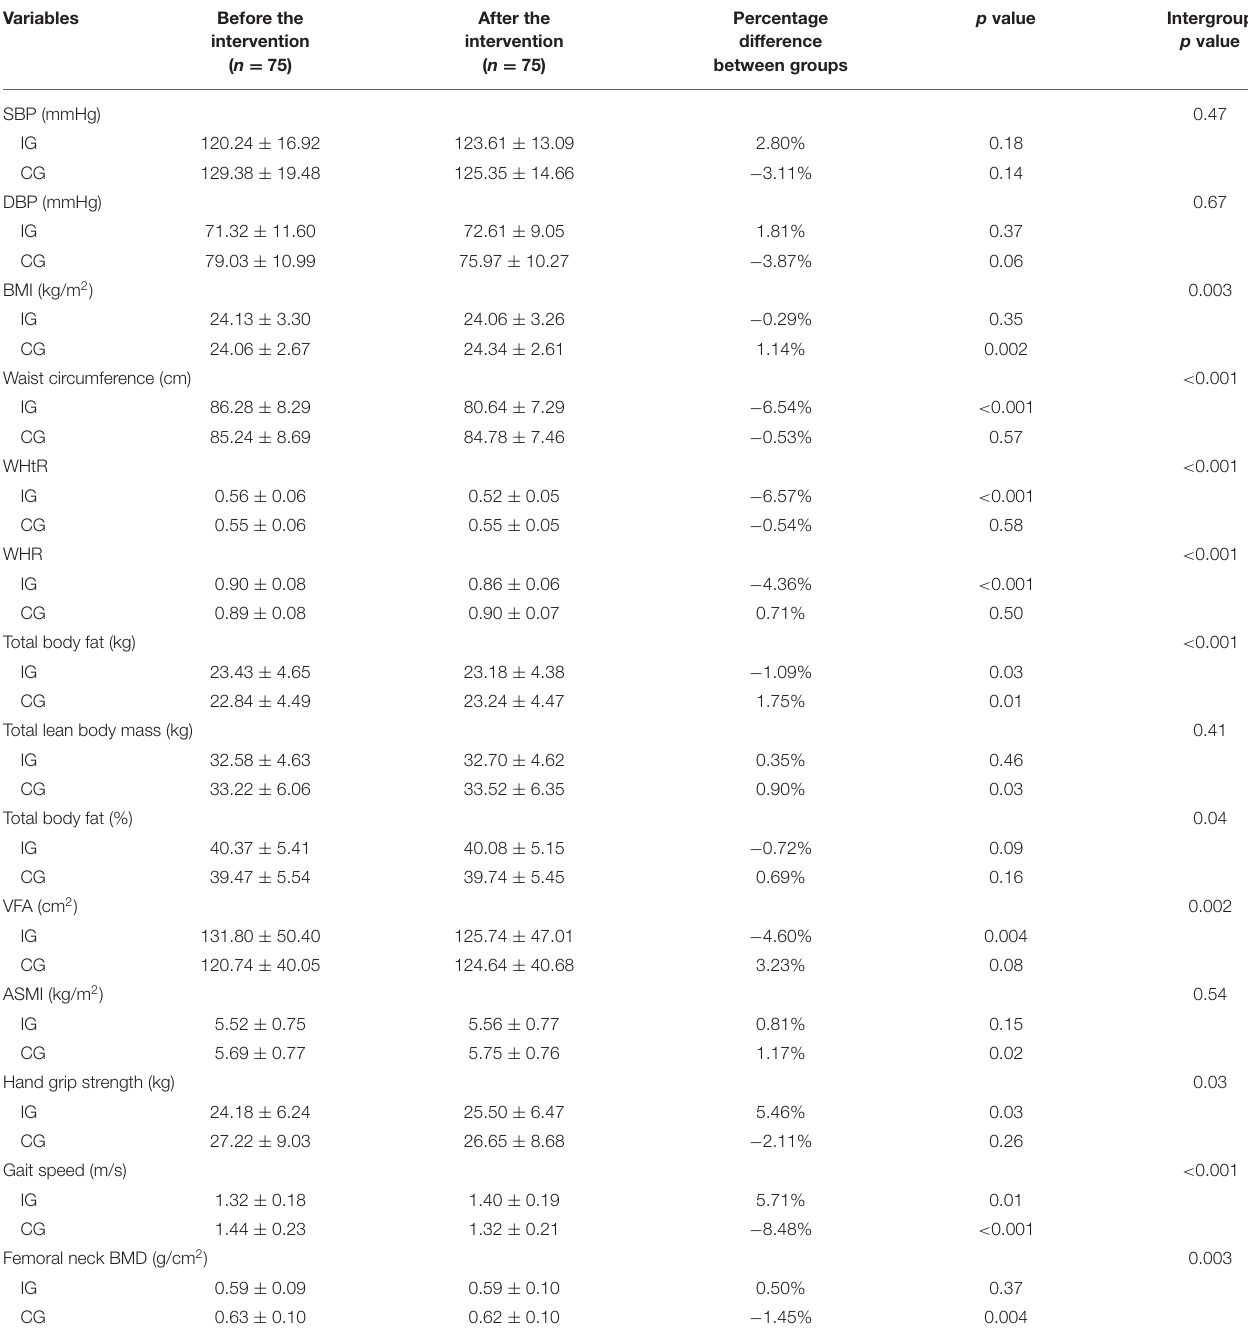
TABLE 3 | Characteristics of the study population who received kickboxing training or control before and after intervention.